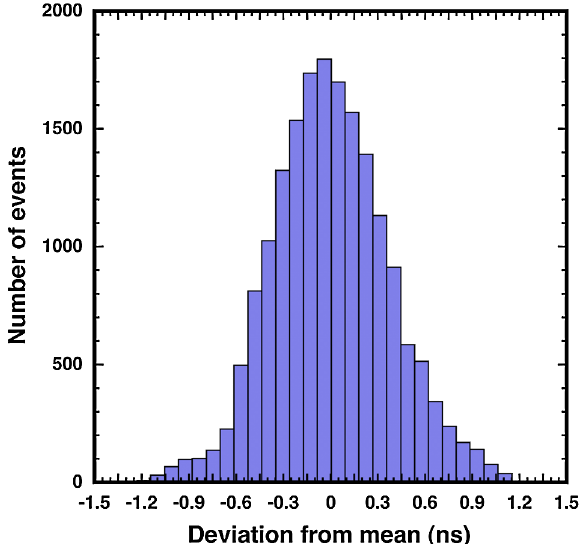
FIG. 13. (Color) Prefire probability and system jitter, versus switch pressure at 100 kV charge voltage. Data are shown for pure SF6. Roughly 10 000 shots were acquired to generate this plot.